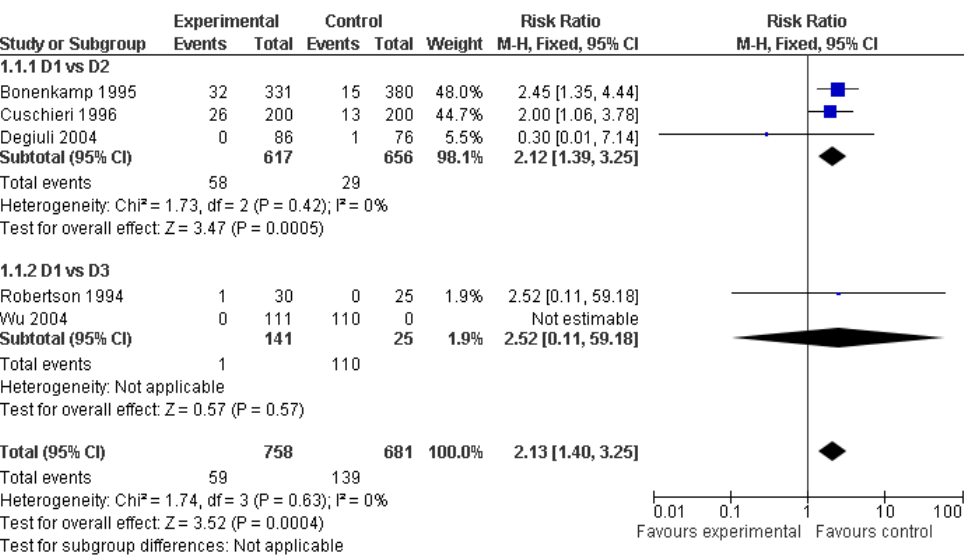
FIGURE 1 – Meta-analysis of in-hospital mortality rate. Effects estimates (odds ratio; 95% CI). Pooled treatment effect is shown as a diamond that spans the 95% CI. No statistical heterogeneity between studies results. Overall effect with significant statistical difference favouring D1 lymphadenectomy